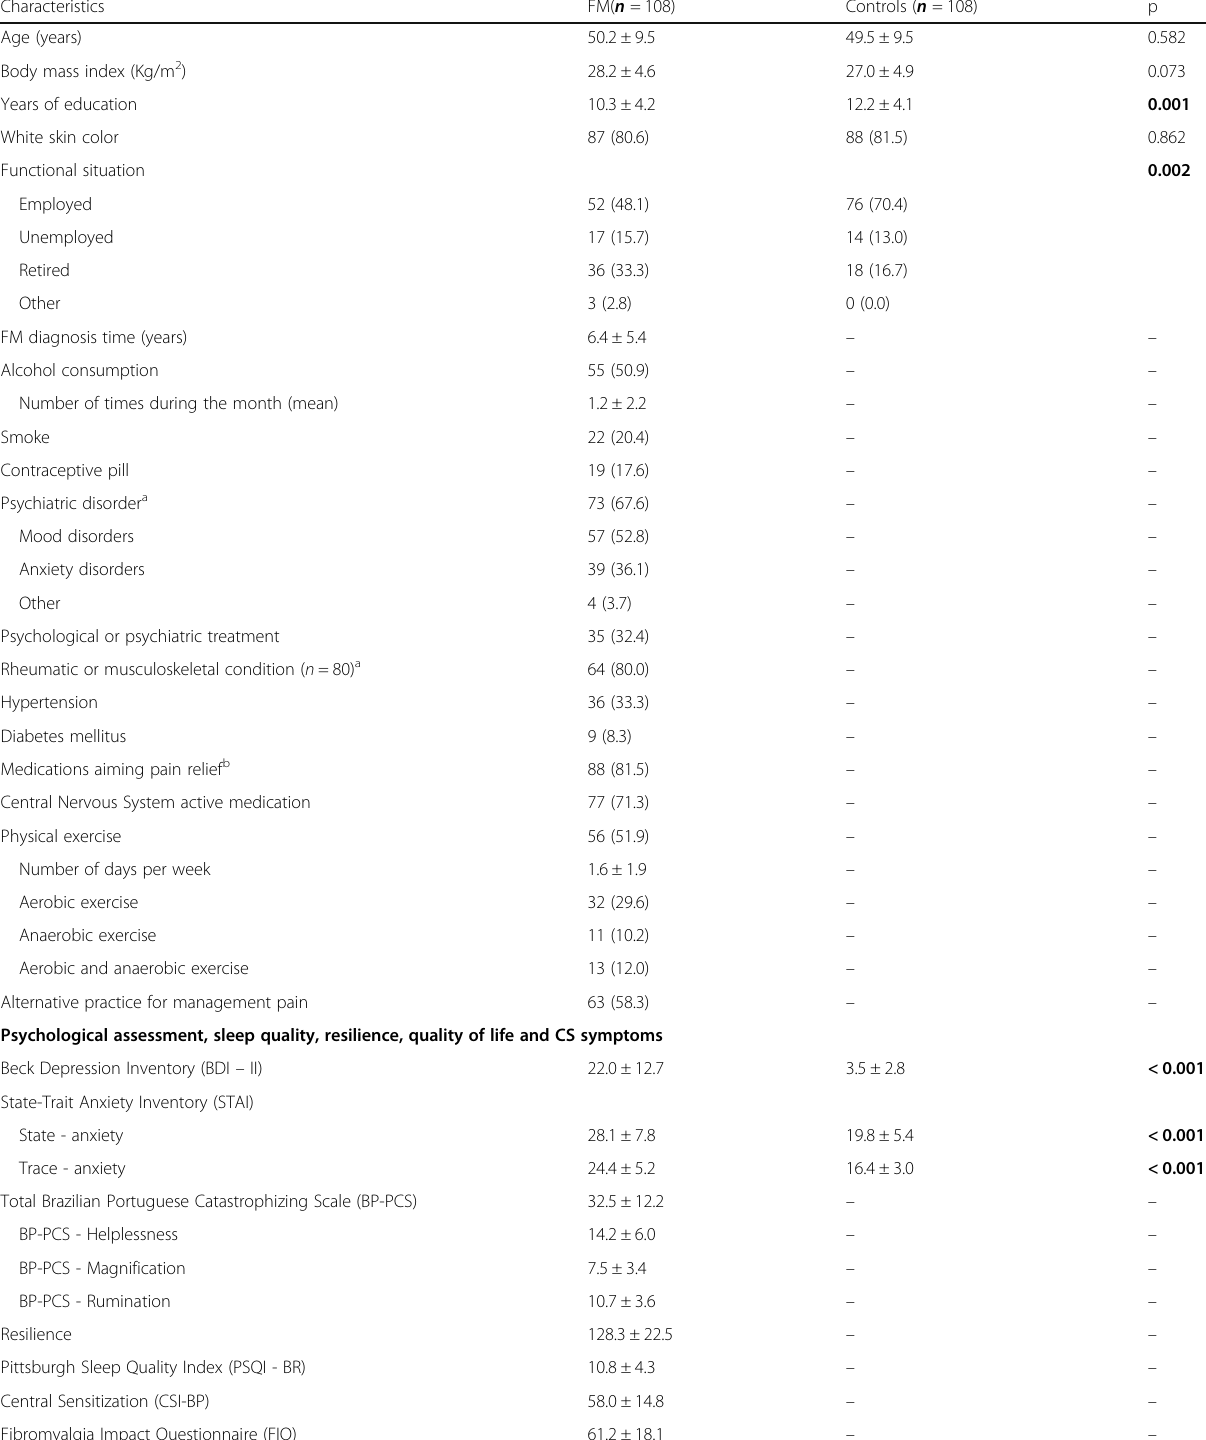
Table 1 – Socio-demographic and clinical characteristics of FM patients and controls ( n =